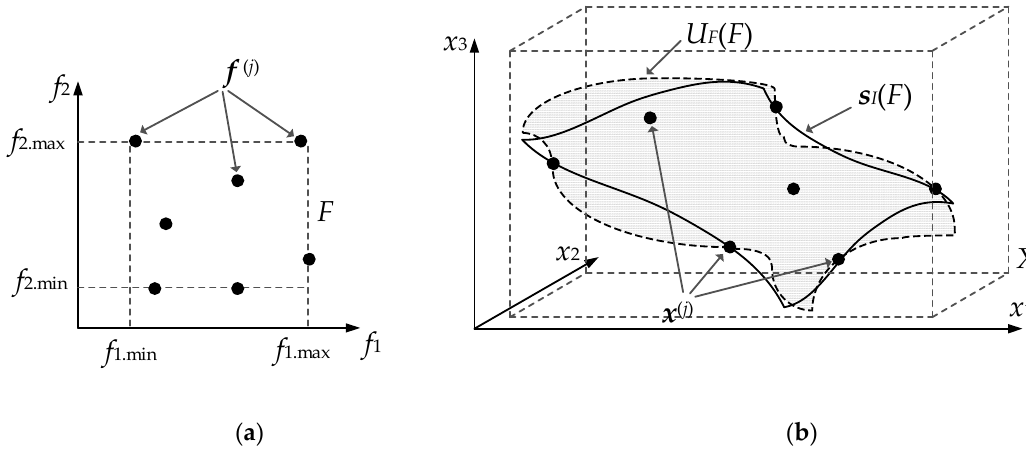
Figure 1. Fundamentals of the nested kriging concept (here, shown for two performance figures and three-dimensional parameter space): ( a ) objective space F , ( b ) parameter space X , the reference designs, the optimum design manifold U F ( F ), and the first-level model image s I ( F ). The manifolds U F ( F ) and s I ( F ) do not coincide for all f ∈ F but the agreement is perfect for all reference designs x ( j ) , which are optimal in the sense of (1).